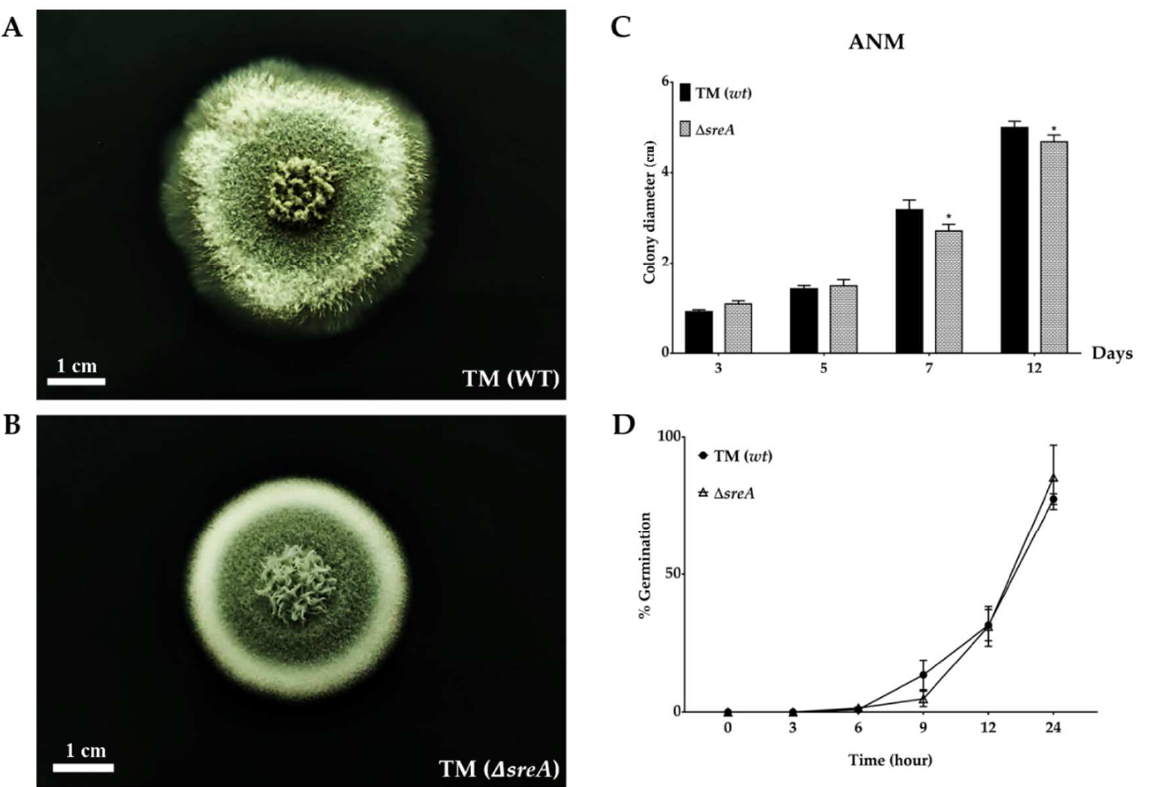
Figure 1. Colony growth and conidial germination of T. marneffei strains. T. marneffei strains were cultured on ANM agar at 25 °C and observed for up to 12 days. The typical green velvety colony is observed in the 7-day-old FRR2161 strain ( A ). A colony of ∆ sreA (7 days) showed a similar appearance but was more compact ( B ). The colony diameters of the ∆ sreA are significantly reduced compared to the wild type ( p value < 0.01) ( C ). The percentage of germination is determined by one thousand total cell counts ( D ). Asterisk (*) indicates data that significantly differed based on Tukey’s test.